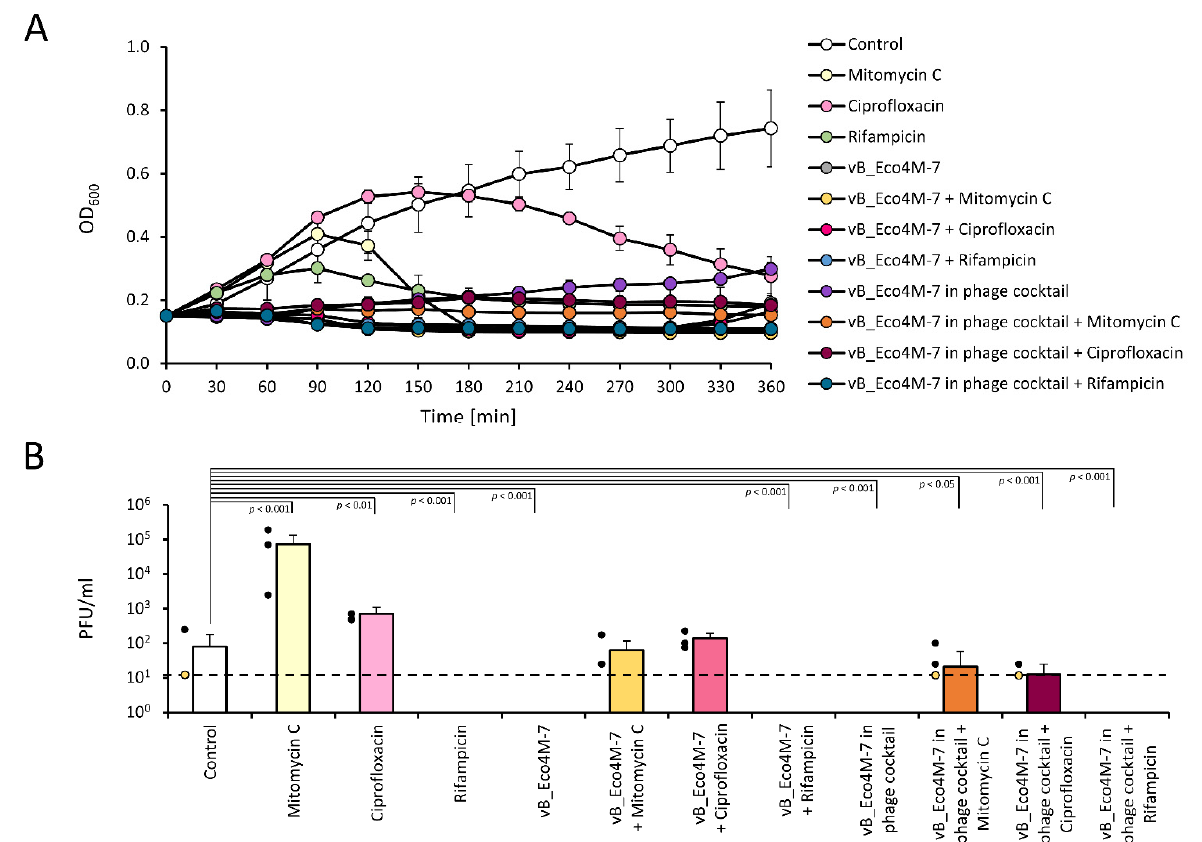
Figure 6. Efficiency of Shiga toxin-converting prophage induction in the E. coli O157:H7 (ST2-8624) strain growing in LB medium supplemented with different antimicrobial agents, individually or in the following combinations: mitomycin C (2 µg/mL) or ciprofloxacin (0.03 µg/mL) or rifampicin (8 µg/mL), the vB_Eco4-M7 phage (MOI of 0.1) or the phage cocktail (MOI of 0.1), the vB_Eco4M-7 phage (MOI of 0.1) mixed with mitomycin C (2 µg/mL), ciprofloxacin (0.03 µg/mL) or rifampicin (8 µg/mL), the phage cocktail (MOI of 0.1) mixed with mitomycin C (2 µg/mL) or ciprofloxacin (0.03 µg/mL) or rifampicin (8 µg/mL). Results are shown as bacterial culture density measured at OD 600 ( A ) and the number of infective phage particles per ml of suspension (PFU/mL) after a 6 h incubation with tested agents ( B ). The black dashed line represents the lower limit of detection ( B ). Mean values from three independent experiments are shown with error bars indicating SD. The black dots next to the columns denote datapoints from individual experiments. Values below the limit of detection (no plaques observed) are marked with yellow dots. Note that in some cases the bars are smaller than the sizes of symbols. Statistical analyses were performed using the one-way ANOVA ( p value < 0.05 was considered statistically significant).